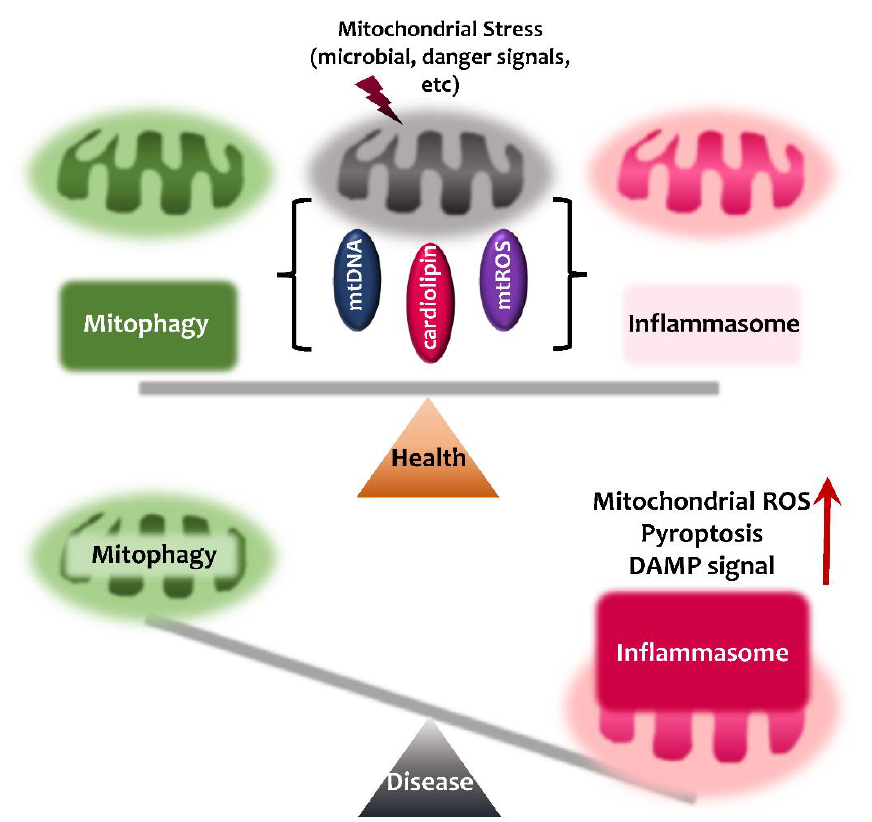
Figure 3. Inflammasome and mitophagy in health and disease. Balance between inflammasome and mitophagy activation is required to prevent the harmful inflammatory responses of microbial or other danger signals, and to maintain protective immunity and good health. Any disproportion between activation of inflammasome and mitophagy causes sustained mitochondrial stress leading to pyroptosis and pathological inflammation.